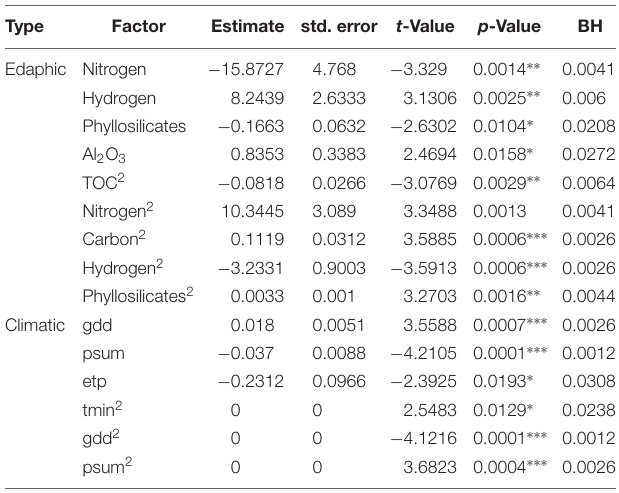
FIGURE 2 | Archaeorhizomycetes OTU relative abundance correlations with 10 edaphic factors (A) abiotic and 12 biotic variables (B) , of which 6 fungal genera and 6 plant species. Correlations are described as Spearman correlations, with positive interactions in blue, and negative in red. The shading color and size of the circles correspond to the strength of the correlation, on an absolute scale between 0 and 1.